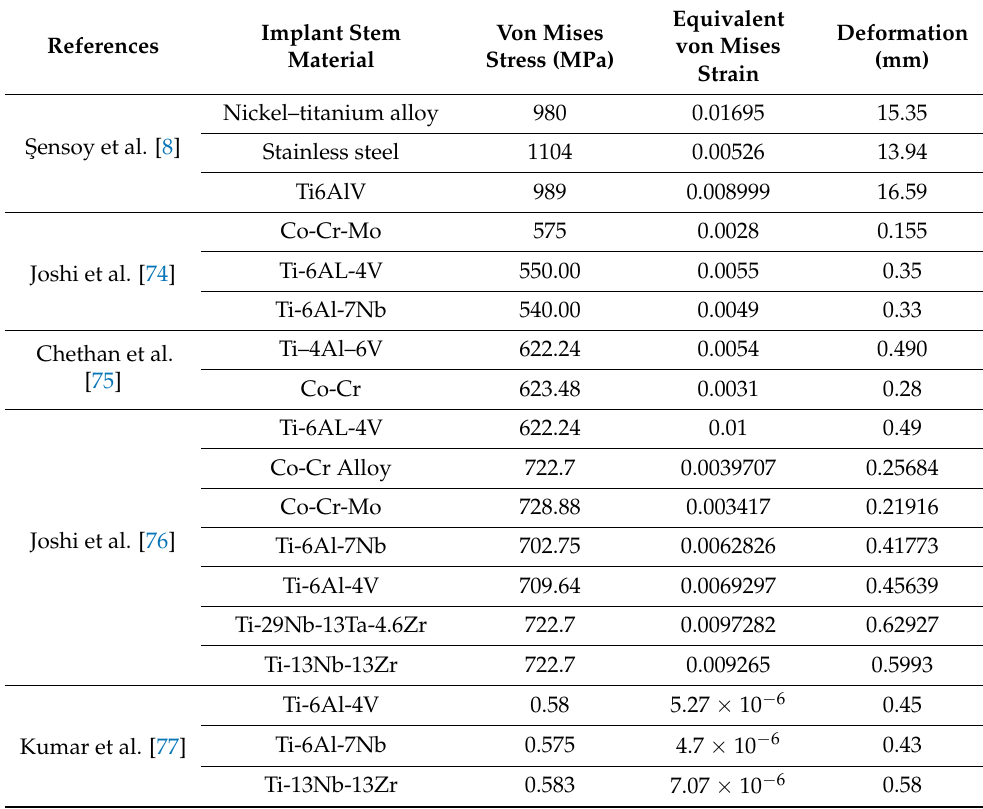
Table 2. Comparative Evaluation of von Mises stresses, strains, and deformations for various material